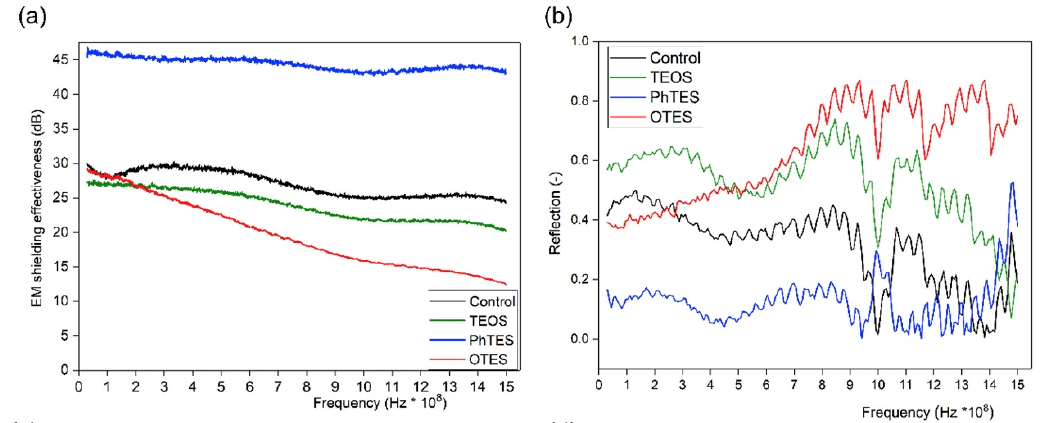
Figure 27. ( a ) EM shielding effectiveness of silanized metal coated fabric and ( b ) reflection effectiveness (Reproduced from [179], with kind permission of Elsevier).